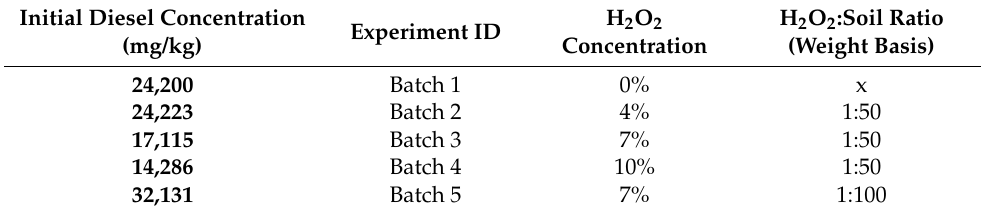
Table 1. The different experimental scenarios used in the